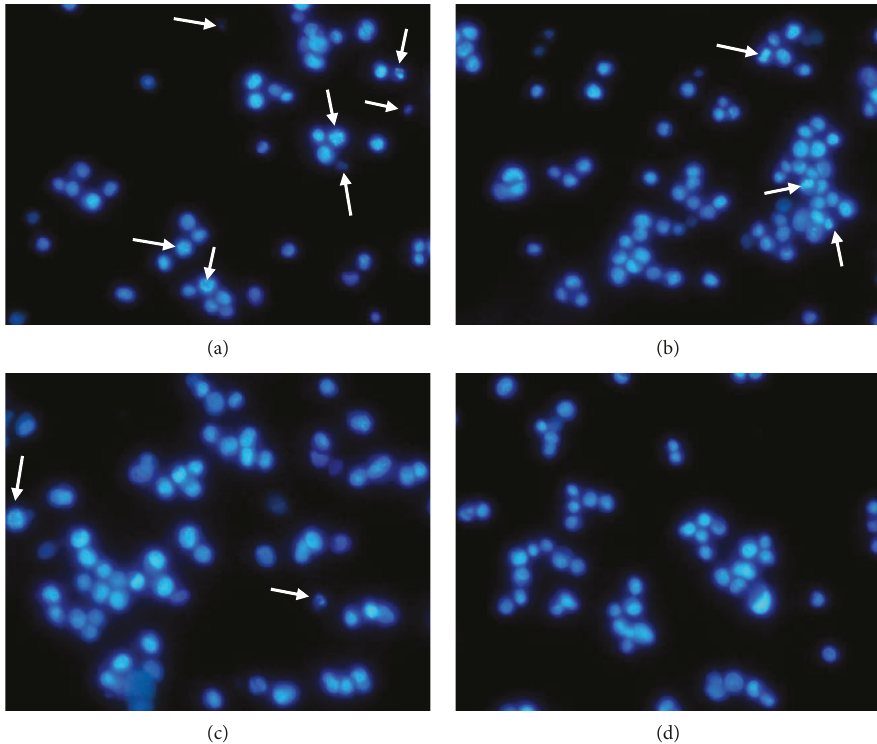
Figure 5: schSEA diminishes nuclei condensation in PNT2 cells: (a) negative control, (b) 6.25 μ g/ml schSEA, (c) 12.5 μ g/ml schSEA, and (d) serum-fed (positive control). Condensed and morphologically altered nuclei indicated by arrows. Cells were stained with Hoechst 33258 dye and nuclei visualized with fl uorescence microscope (magni fi cation 40x) (Olympus DP 72,